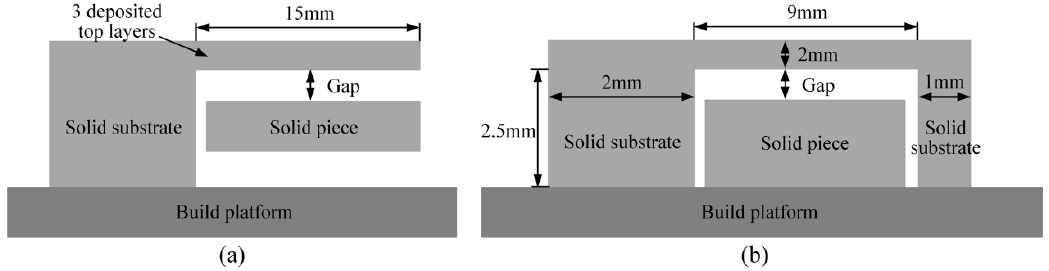
Figure 4. Different deformation evaluation models in ( a ) previous simulation study and ( b ) experiment study.